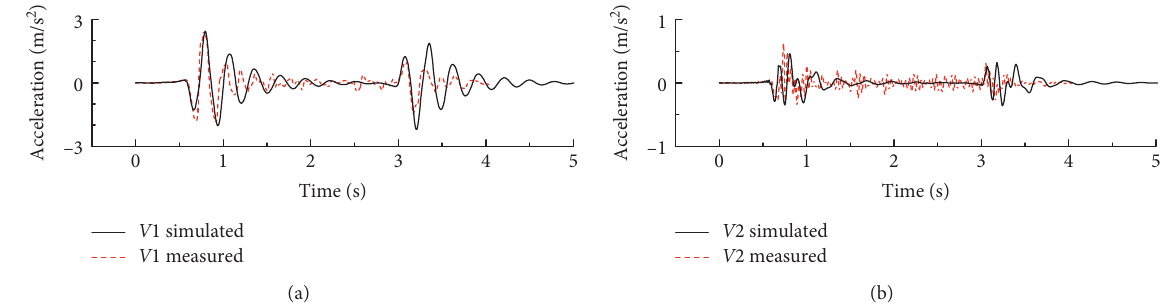
Figure 13: Comparisons of the simulated acceleration time histories with the measured ones.